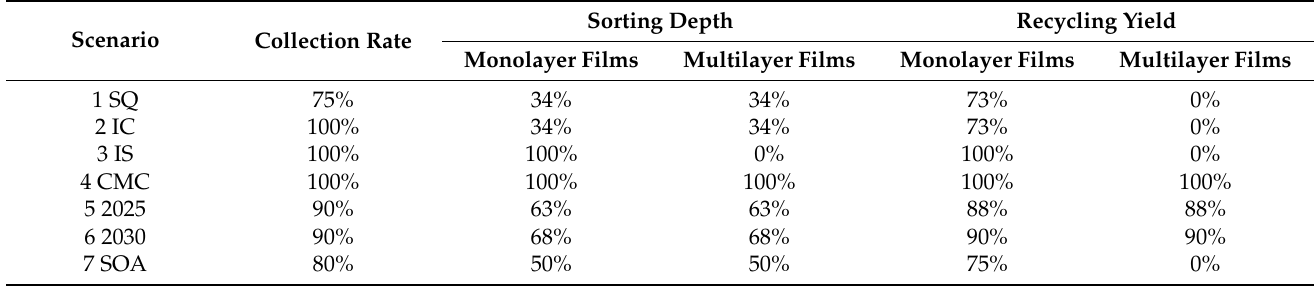
Table 1. Overview of the collection rates, sorting depths and recycling yield in the evaluated